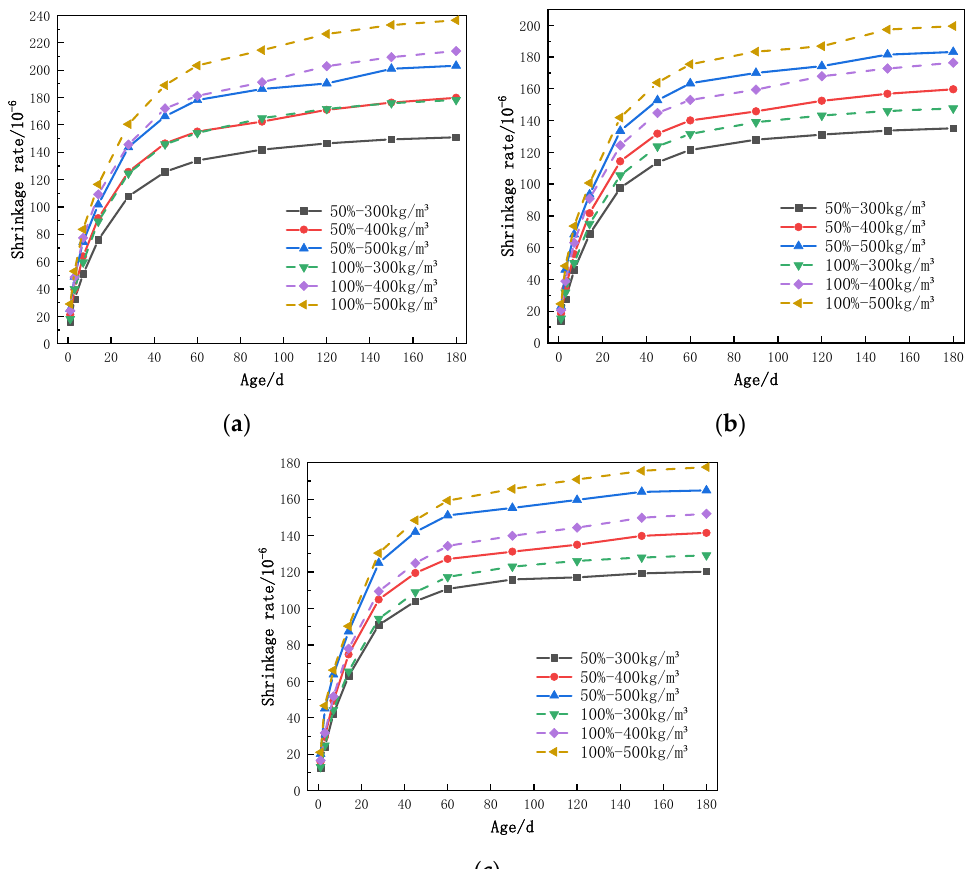
Figure 8. Effect of cementitious material content on the drying shrinkage performance of RAC: ( a ) JD-HBRAC, ( b ) KL-HBRAC, and ( c ) EKL-HBRAC.